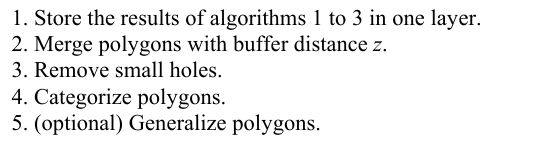
Figure 14. Algorithm 4 for combination and finalization